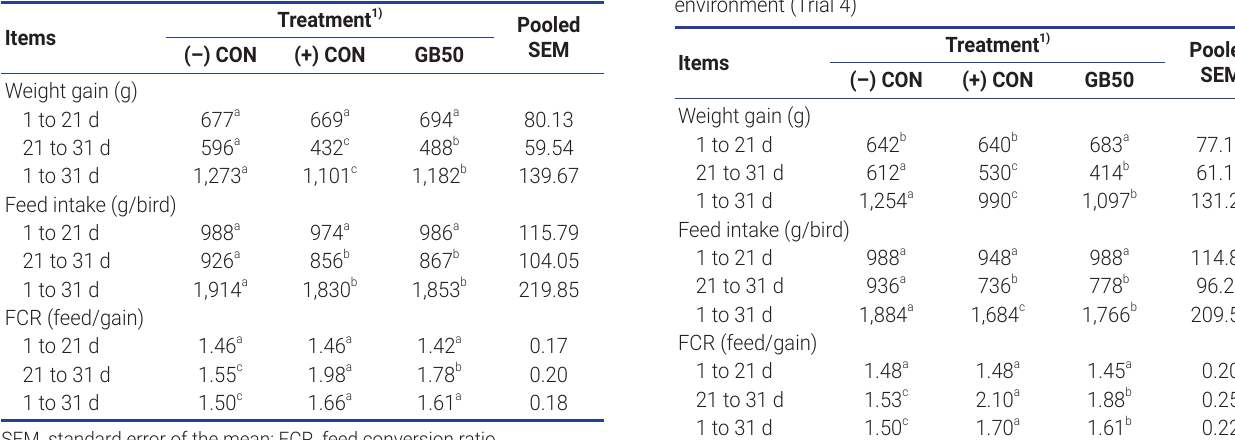
SEM, standard error of the mean; FCR, feed conversion ratio. 1) (–) CON, control group without stress; (+) CON, control group with stress; GB50; gamma aminobutyric acid 50 mg/kg. a-c Means within rows with no common superscript differ significantly